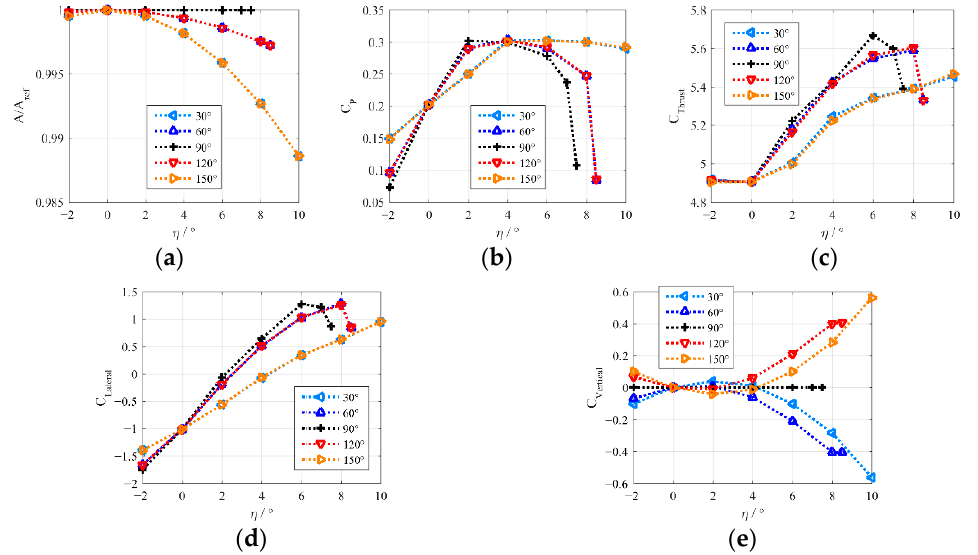
Figure 10. Overall performance of a wind turbine with different incline angles: ( a ) swept area, ( b ) C P , ( c ) C Thrust , ( d ) C Lateral and ( e ) C Vertical